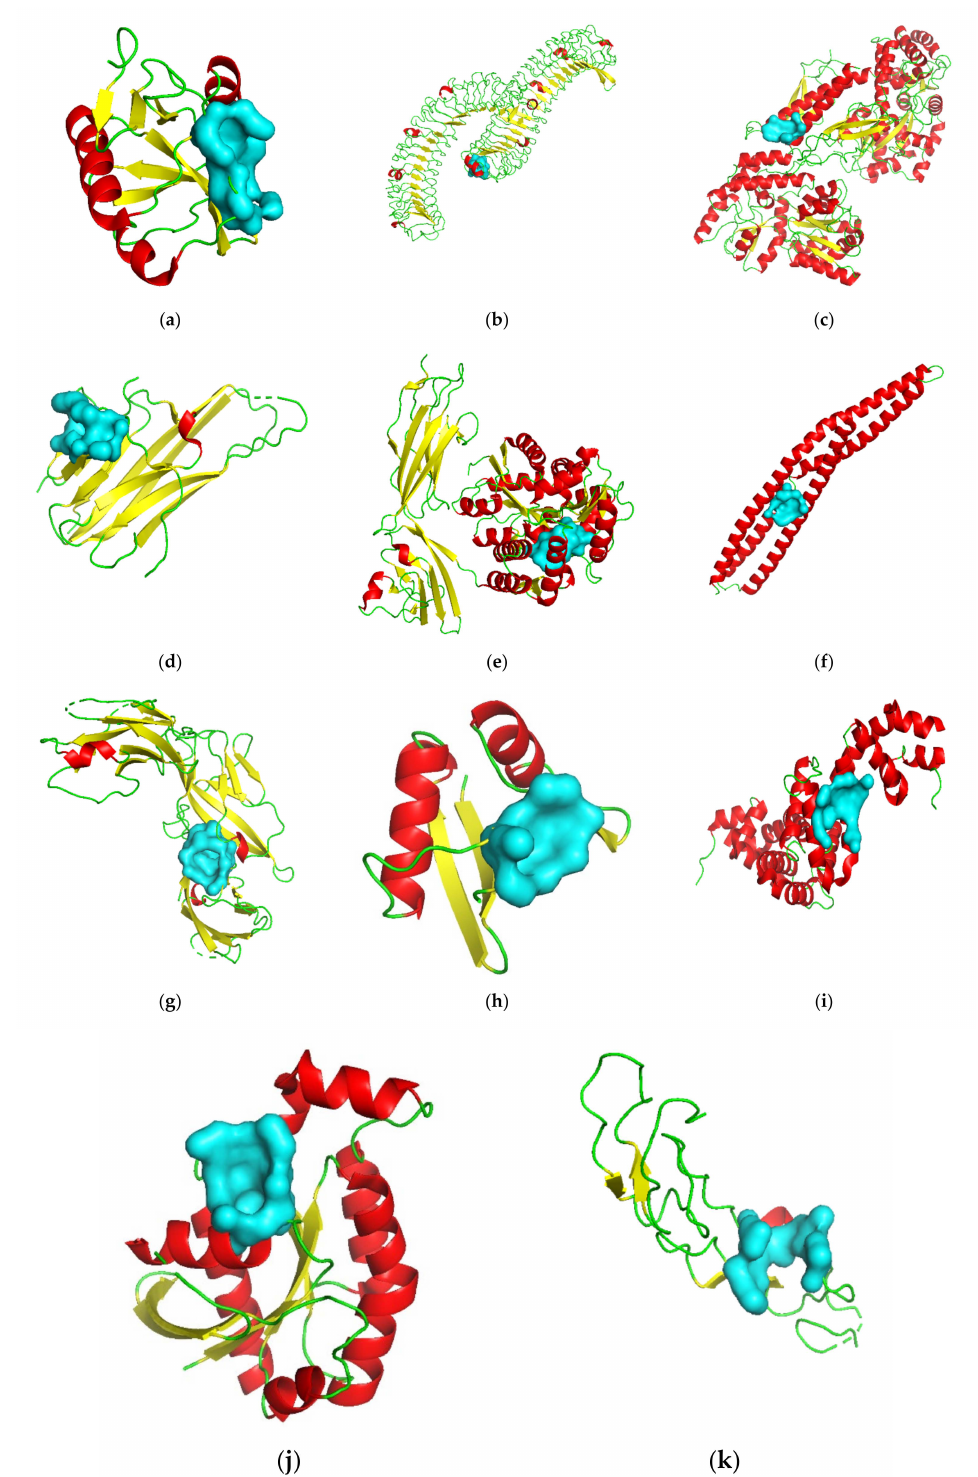
Figure 3. The best druggable pocket (shown in cyan surface mode) of each target predicted by PockDrug. A total of 11 candidate genes with known protein crystal structures and with one or more druggable pockets are presented, including CD209 ( a ), LGR5 ( b ), CRHR2 ( c ), FAS ( d ), AGER ( e ), BIN1 ( f ), IL1RL1 ( g ), PARD6A ( h ), RGS7 ( i ), RHOU ( j ) and TNFSF10 ( k ). All the predicted information by PockDrug is summarized in Table 4 and Table S3. Pockets with druggability scores of 0.5 or more were considered